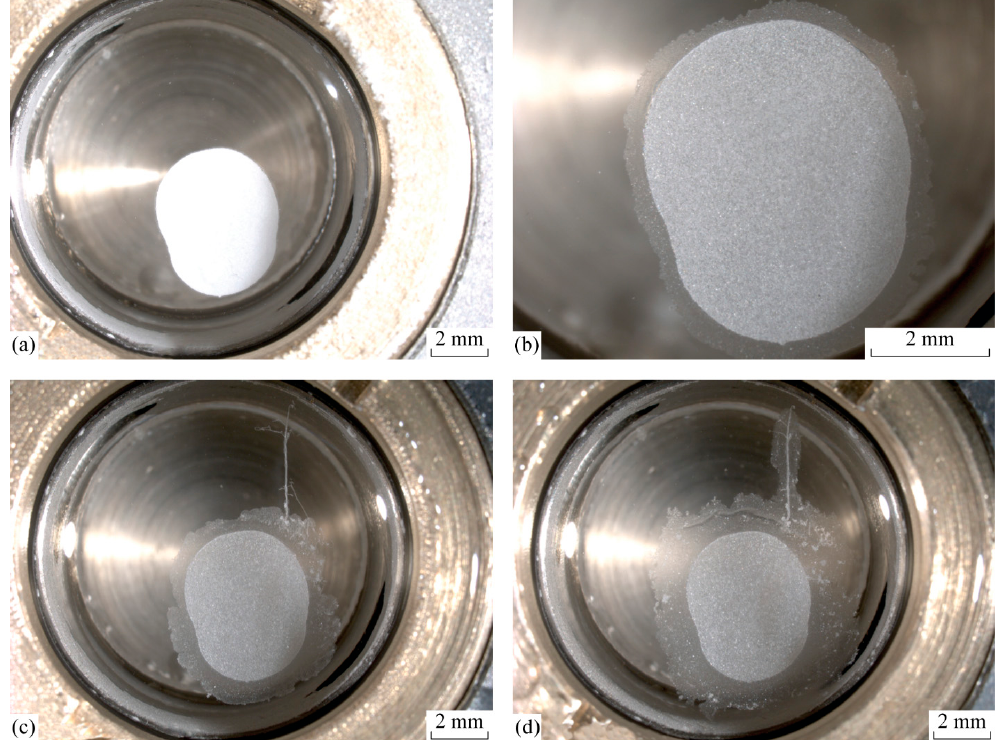
Figure 3. The formation of xenon hydrate from a drop of liquid: ( a ) phase transition (duration < 0.1 s) in the process of supercooling (xenon saturation period of 32 h at + 4 ◦ C and 8 atm); observed at − 13.6 ◦ C, 8 atm; ( b ) the growth of xenon hydrate from water vapor 25 min after the initial phase transition; observed at + 9.0 ◦ C (the temperature was elevated to exclude the presence of ice crystals), 8 atm; ( c ) same as above after 65 min; ( d ) same as above after 150